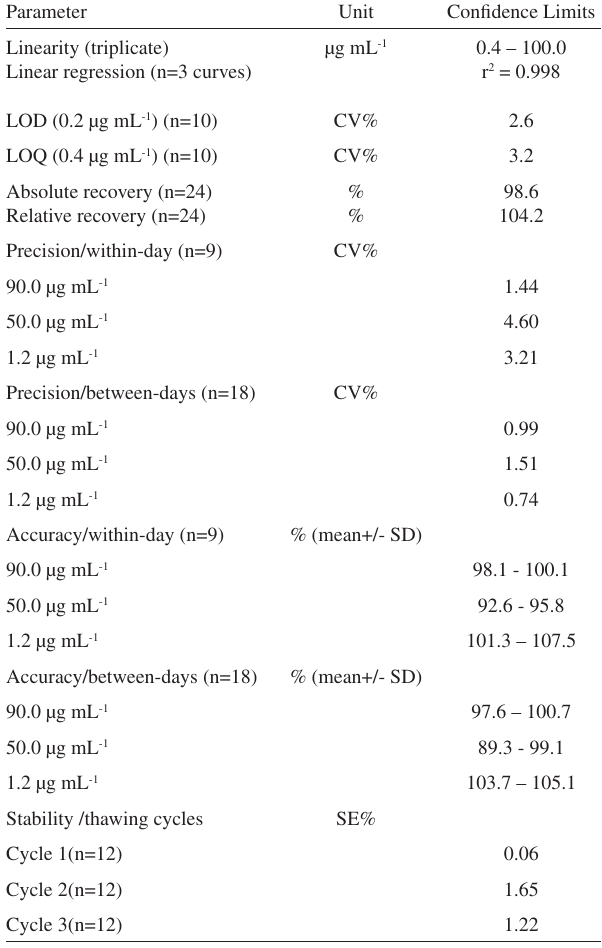
Table 1 - Mean confidence limits of analytical method of fluconazole in plasma.